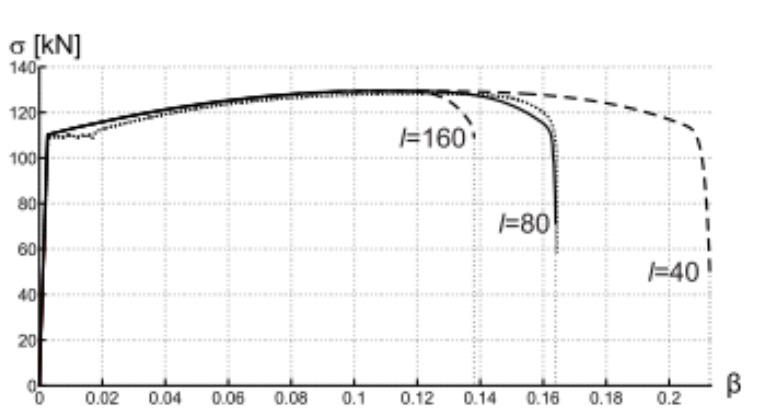
Figure 2: Response curves for a steel bar in numerical simulations with N = 3 and different values of l , and experimental response curve (the dotted line) for l = 80 mm.